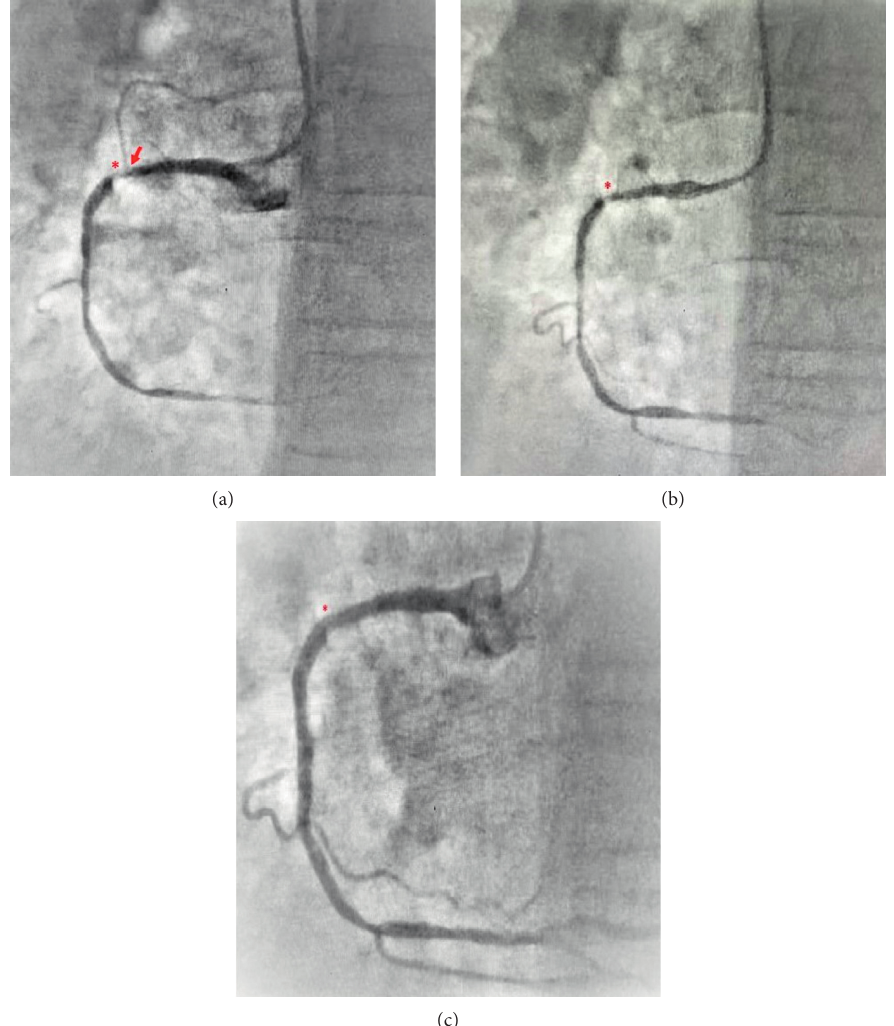
Figure 2: (a)–(c) Sinus node artery before and after PCI. (a) Right coronary angiography showing 95% narrowing in the proximal segment (red asterisk). Note the sinus node artery (SNA) originated from the proximal segment (red arrow). (b) RCA following ballooning. (c) Proximal segment stenting. Note the angiographic disappearance of the SNA (red